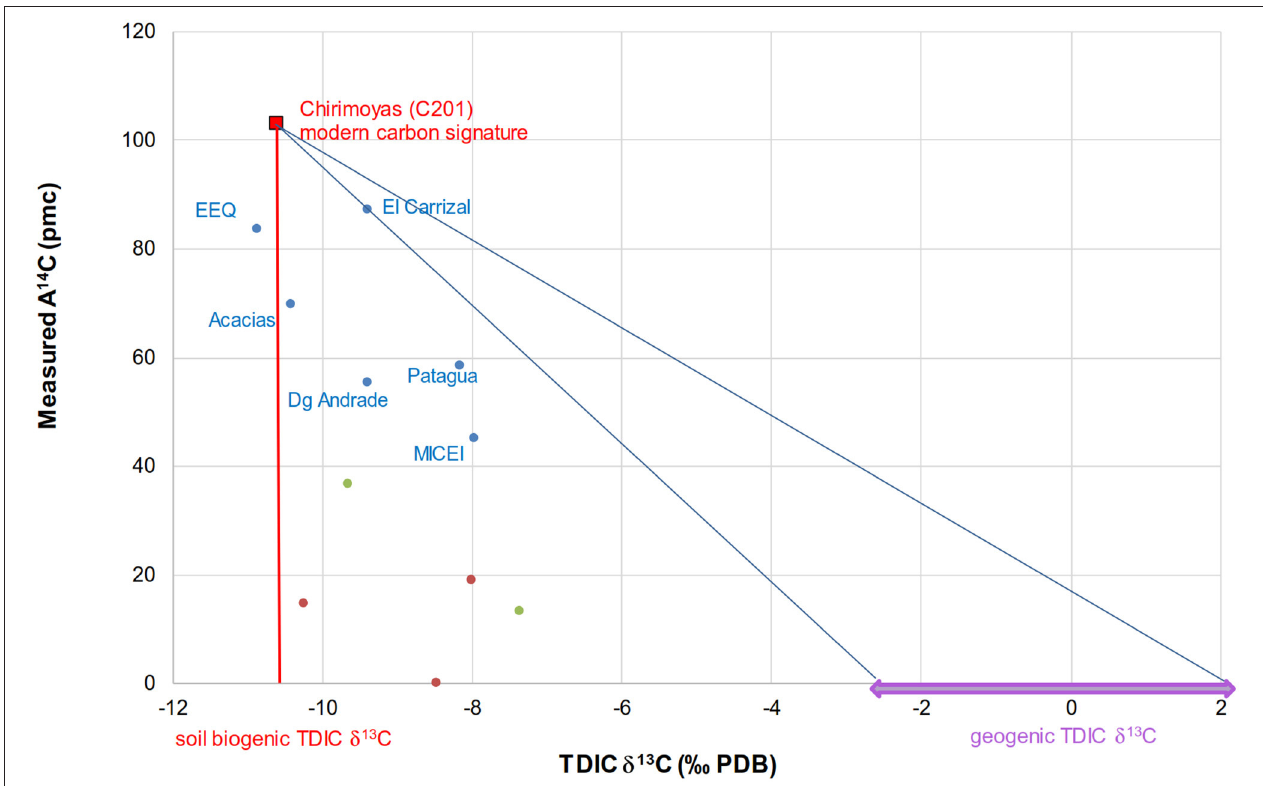
FIGURE 11 | Measured 14 C activity (A 14 C) as a function of measured TDIC δ 13 C for North Chiche wells (blue points), Ilaló wells (red points), and mixed wells (green points). The vertical red line represents the biogenic TDIC δ 13 C signature. The purple arrow represents the acceptable range for deep geogenic TDIC δ 13 C values. The blue lines represent the range of mixing lines between the soil biogenic and geogenic end-members. A 0 values for all stations would stand on the biogenic/geogenic mixing line.